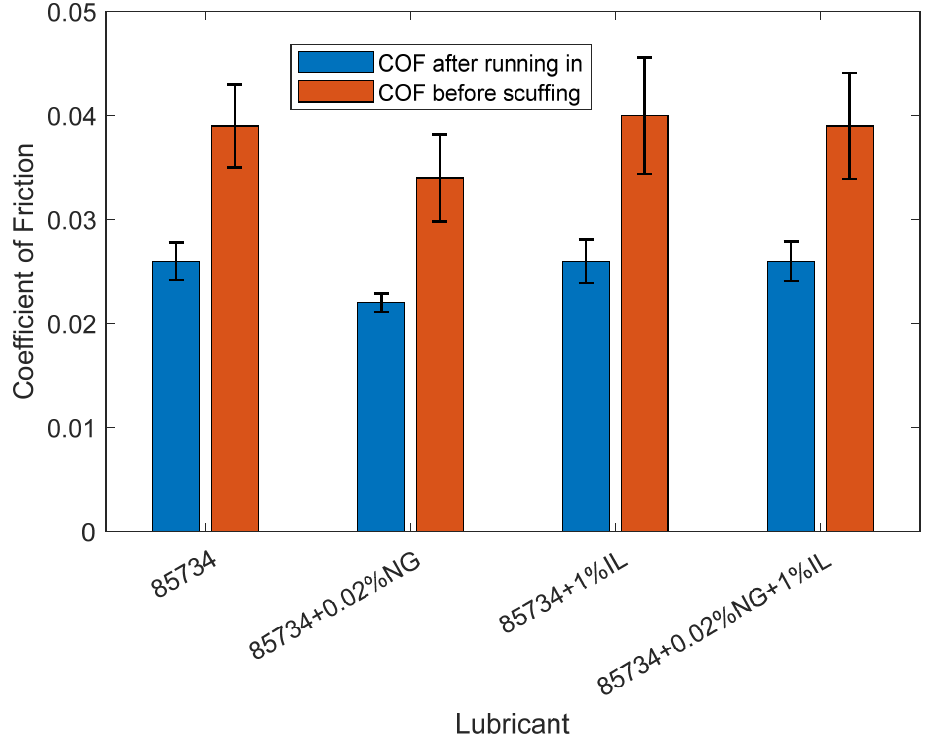
Figure 4. Coe ffi cient of friction (COF) after running in and just before initiation of scu ffi ng in high Figure 4. Coefficient of friction (COF) after running in and just before initiation of scuffing in high Appl. Sci. 2020 , 10 , x FOR PEER REVIEW speed elastohydrodynamic contact. Error with 95% confidence interval. speed elastohydrodynamic contact. Error with 95% confidence interval.